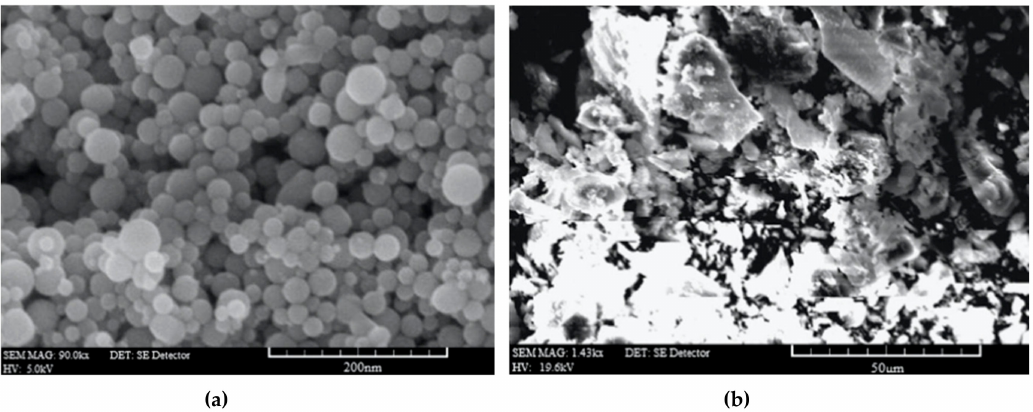
Figure 16. SEM image of the ( a ) nano-Al 2 O 3 and ( b ) rice husk ash. Reprinted with permission from [106]. Copyright © 2016, Elsevier